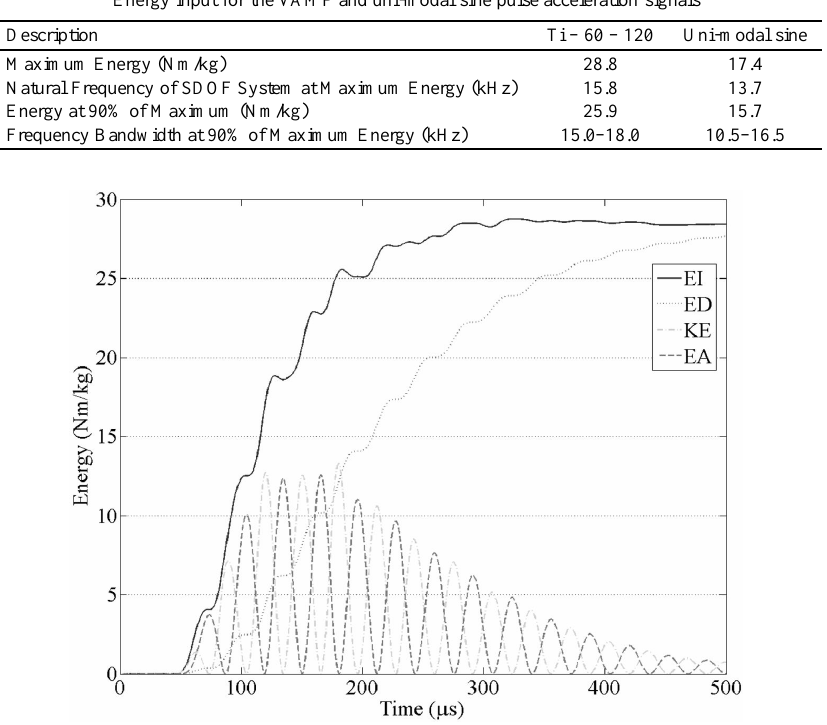
Fig. 14. EIS components for the VAMP acceleration pulse at 15.8